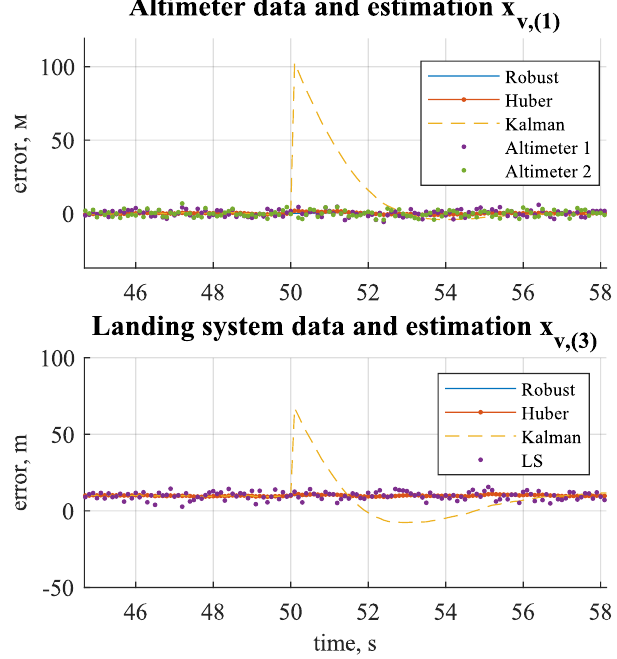
Figure 6. Response of filters to impulse surge at the moment of time t = 50 s. «Robust»—the proposed robust algorithm. «Huber»—M